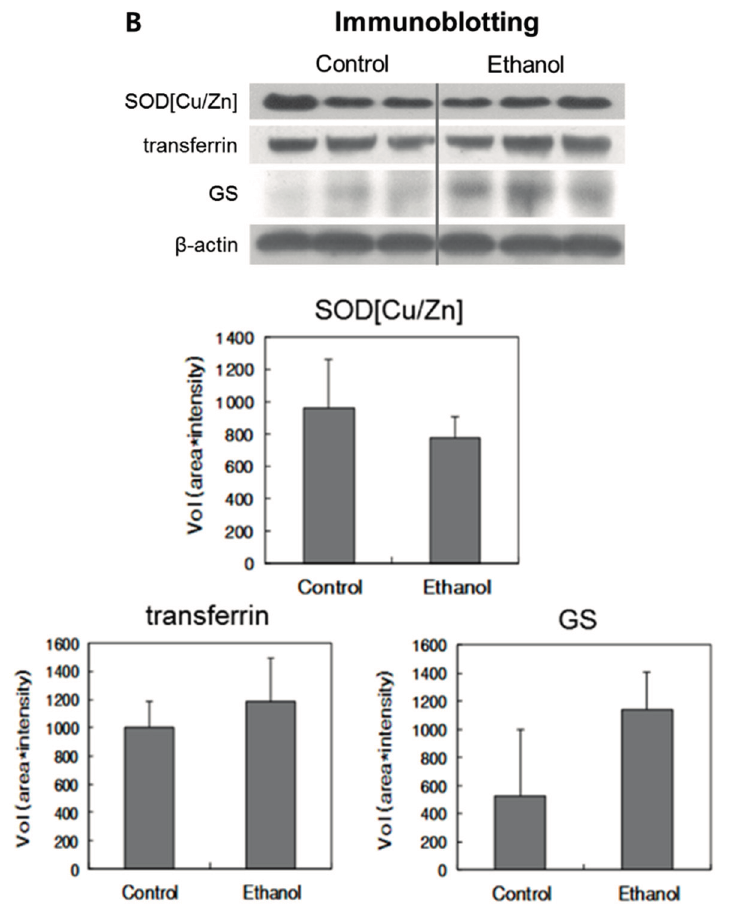
Figure 3. Protein spots and immunoblots of Cu/Zn-SOD, transferrin, and GS in control and ethanol-fed groups. ( A ) Cu/Zn-SOD decreased significantly in ethanol-fed rat liver compared with the pair-fed control. Comparing the Cu/Zn-SOD enzyme expression by spot volume using ImageMaster II, Cu/Zn-SOD in ethanol-fed rat liver was 0.68-fold that of control rat liver in proteomics ( n = 5). Transferrin and GS were significantly increased in ethanol-fed group. Transferrin and GS in ethanol-fed group were 2.1-f and 2.18-fold that of the control group, respectively ( n = 5); and ( B ) In the immunoblotting analysis ( n = 3),